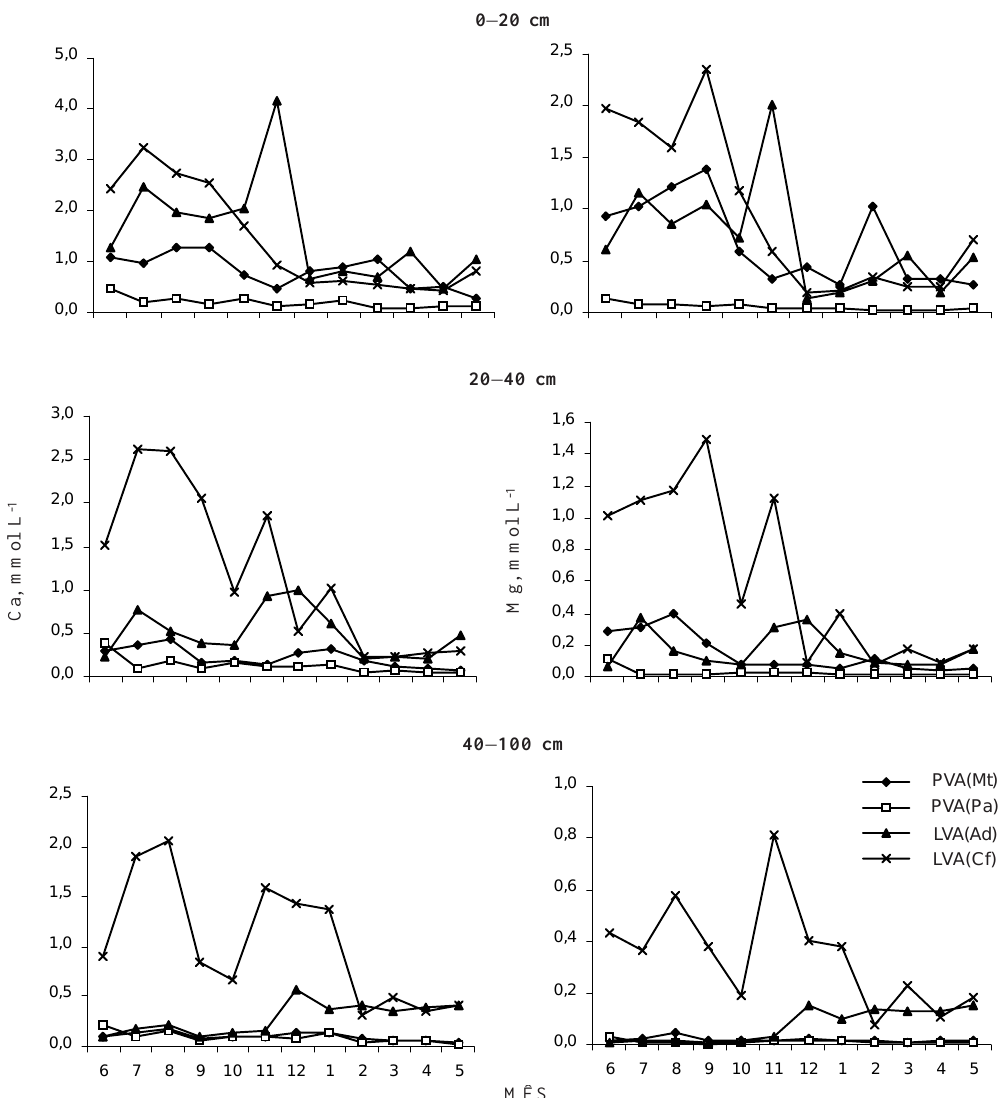
Figura 2. Variação mensal da concentração de cálcio e de magnésio na solução do Argissolo Câmbico sob mata (PVA(Mt)) e sob pastagem (PVA(Pa)) e do Latossolo Vermelho-Amarelo sem cobertura vegetal (LVA(Ad)) e sob cafeeiro (LVA(Cf)), no período de junho de 1996 a maio de 1997, em três profundidades. Média de três